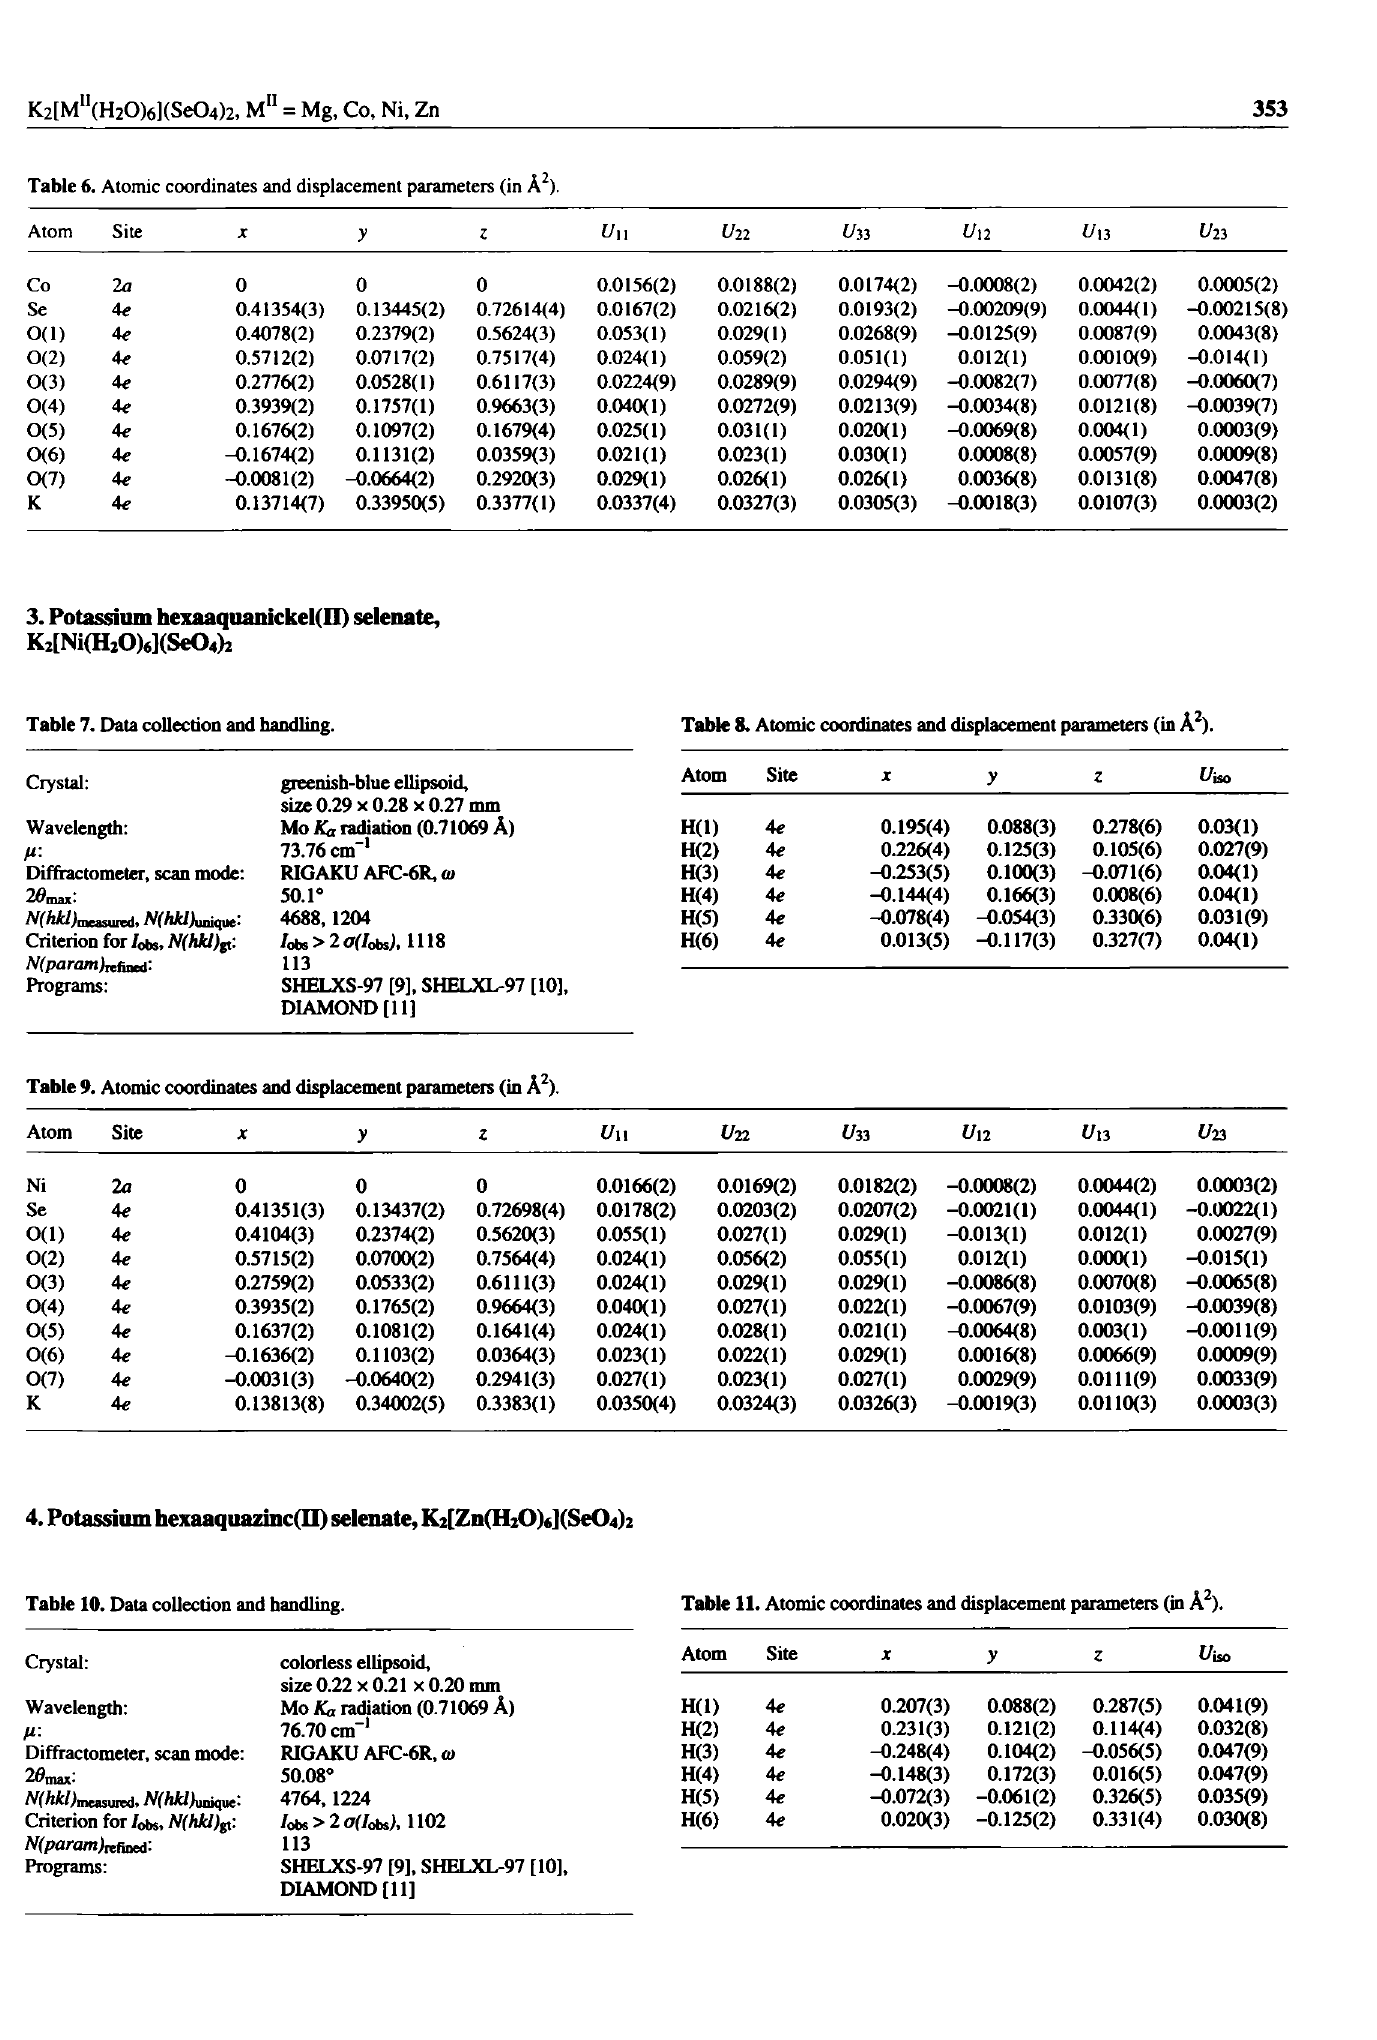
Table 10. Data collection and handling. Table 11. Atomic coordinates and displacement parameters (in À 2